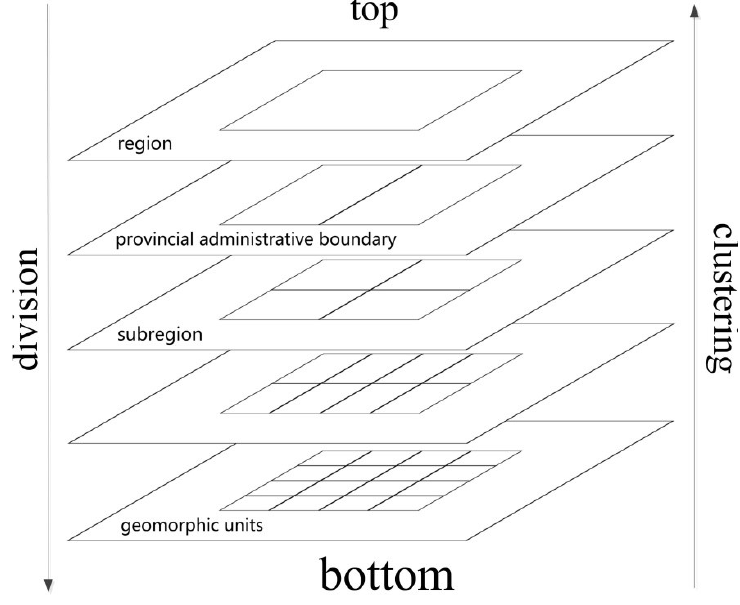
Figure 2. Bottom-up clustering and top-down division.